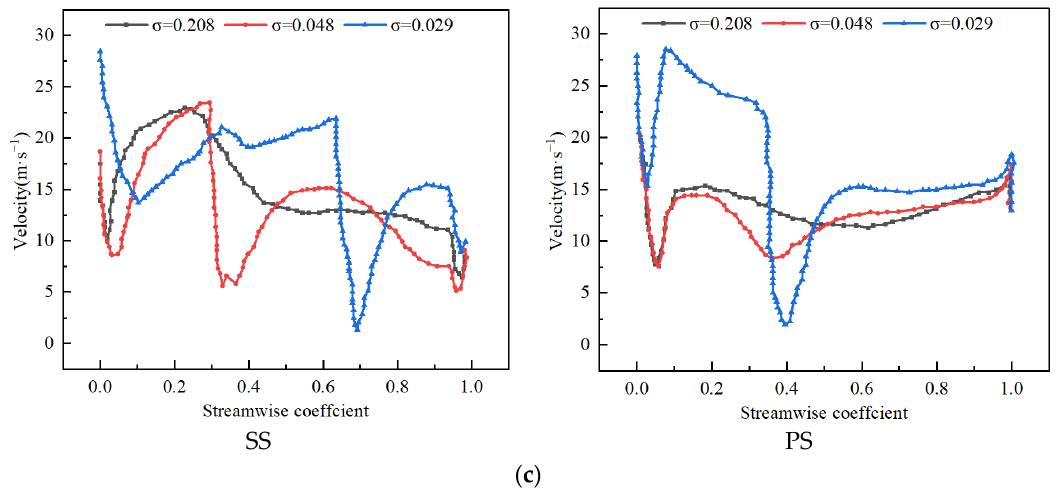
Figure 10. Velocity distribution at 0.5 span under IGVF = 0, 0.1, 0.2. ( a ) IGVF = 0; ( b ) IGVF = 0.1; ( c ) IGVF = 0.2.